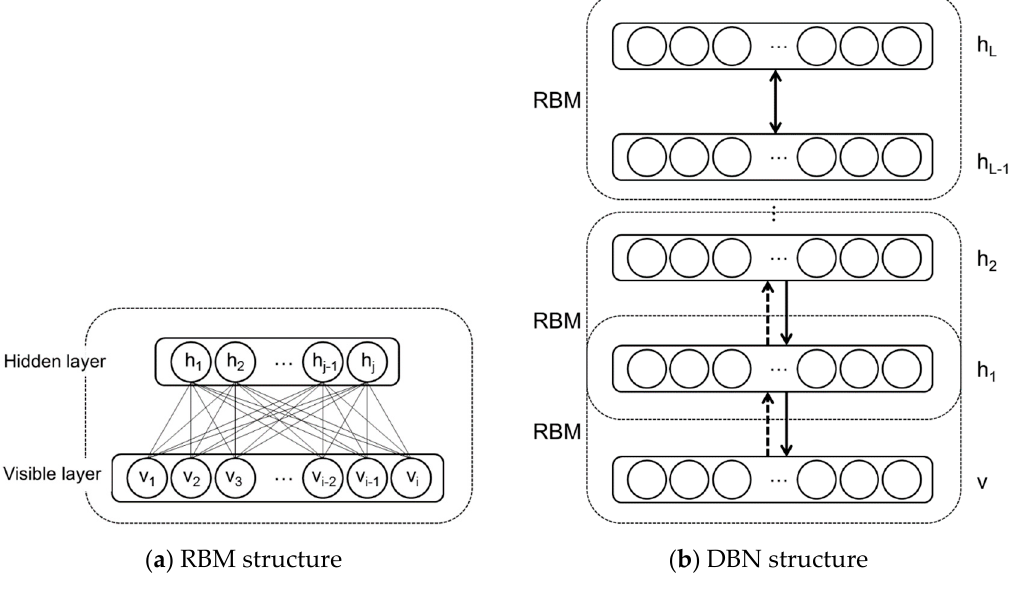
Figure 3. Structure of ( a ) restricted Boltzmann machine (RBM) and ( b ) deep belief network with stacked multiple RBMs.